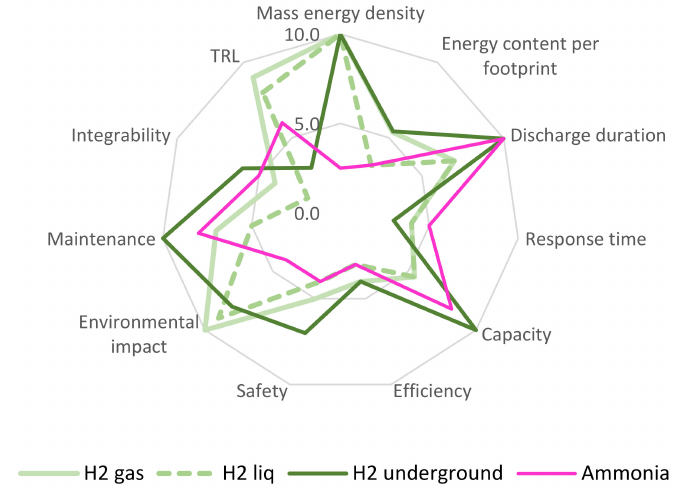
Figure 12. Spider chart of energy carriers, hydrogen and ammonia, and how they perform in each KPI. The data are available in Table 2.